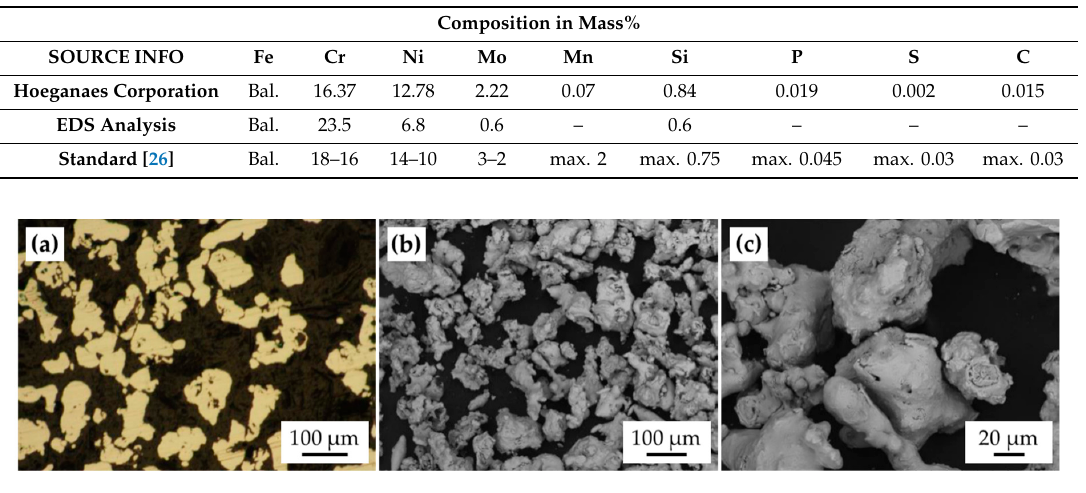
Figure 1. Microscopy analysis of the feedstock. ( a ) optical microscopy (OM) image of the cross-section of the starting particles of 316L; ( b , c ) SEM images of the powder particles.